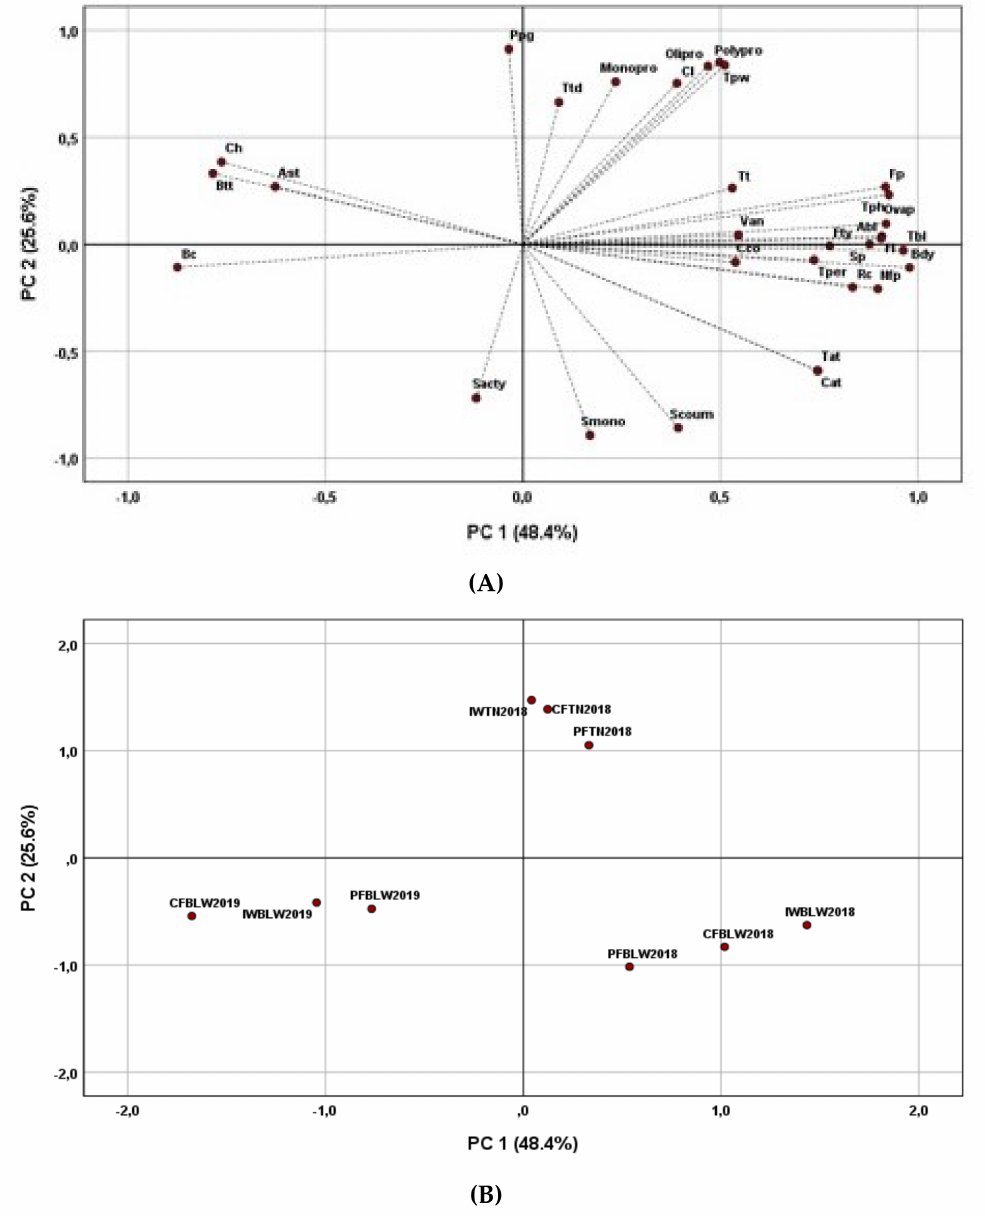
Figure 6. The principal component analysis (PCA; PC1 and PC2) for the different phenolic parameters and sensory attributes of the red wines submitted to cross-flow microfiltration and plate filtration: ( A ) the projection of sensorial attributes and phenolic parameters; ( B ) the projection of red wine